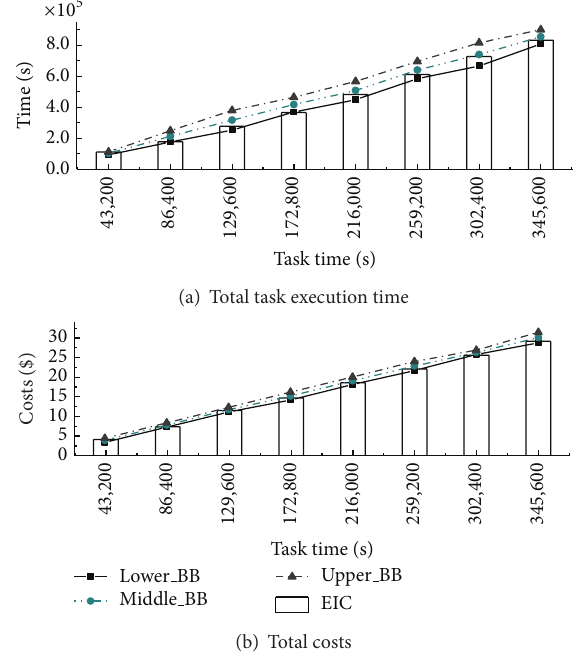
Figure 23: Comparison of actual EIC outputs (execution time and cost) and estimations according to the task